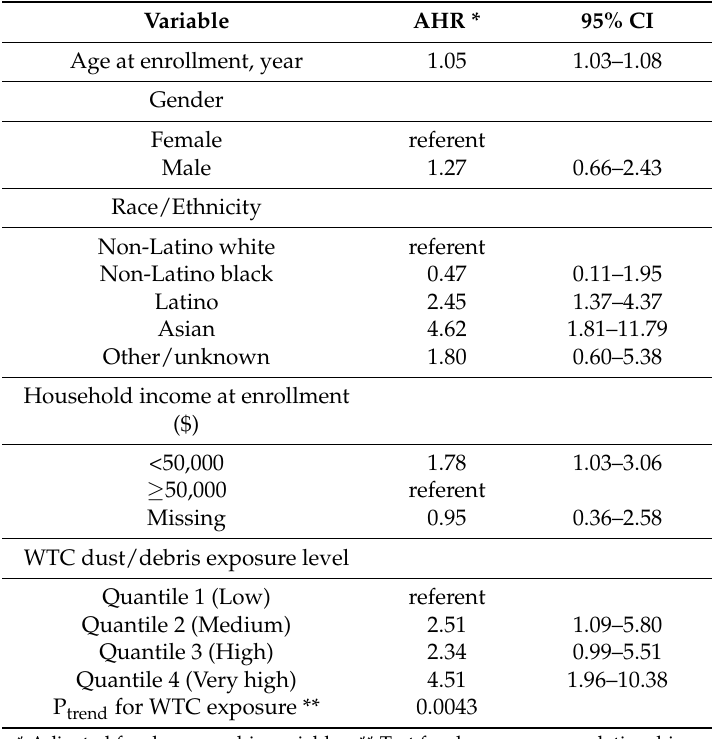
Table 3. Adjusted hazard ratios (AHR) for self-reported physician-diagnosed pulmonary fibrosis (PF) according to socio-demographics and WTC dust exposure ( N = 19,300).